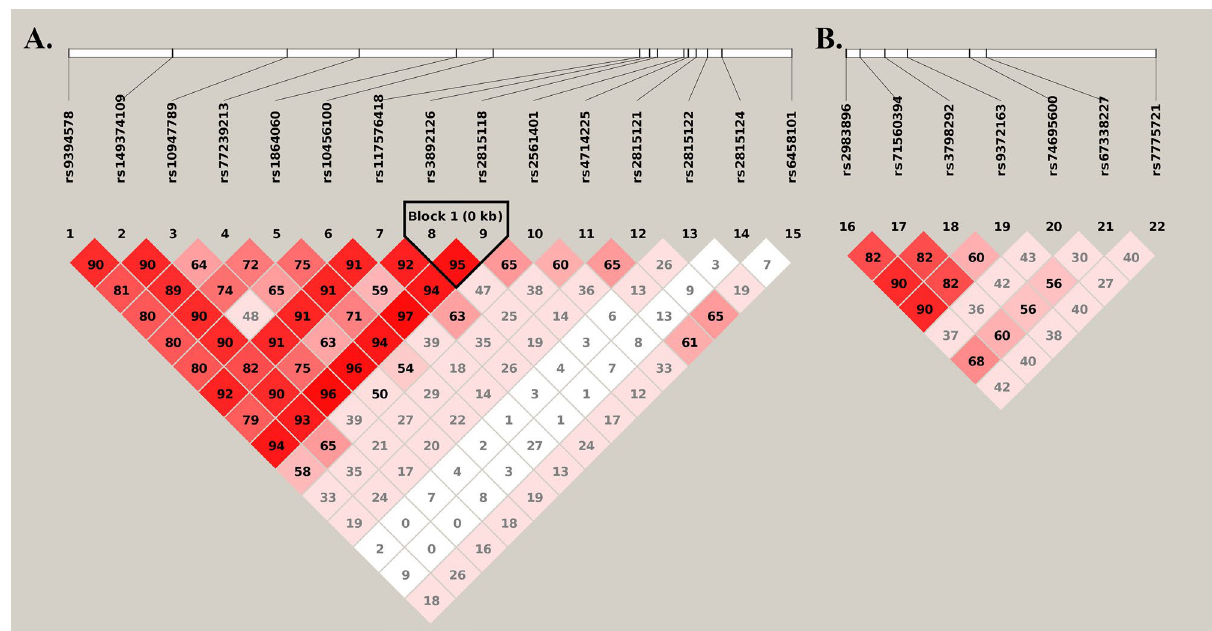
Figure 1. Linkage disequilibrium plots for gene KCNK5 and FHL5. ( A ) Linkage disequilibrium plot for gene KCNK5 ; ( B ) Linkage disequilibrium plot for gene FHL5 .